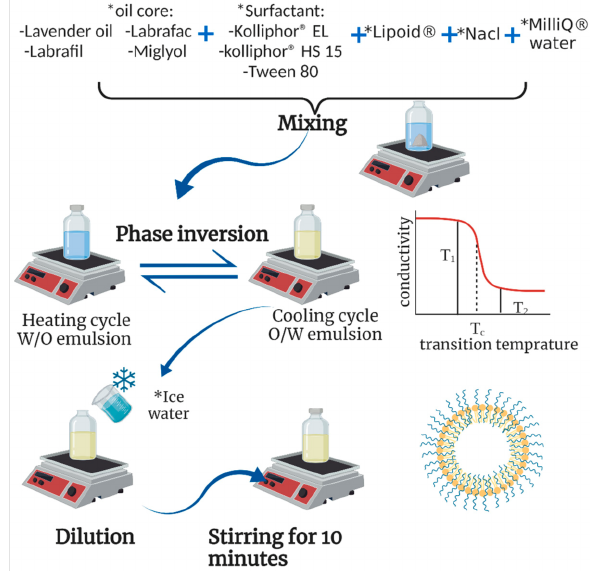
Figure 1. Formulation steps of lipid nanocapsules. * Essential